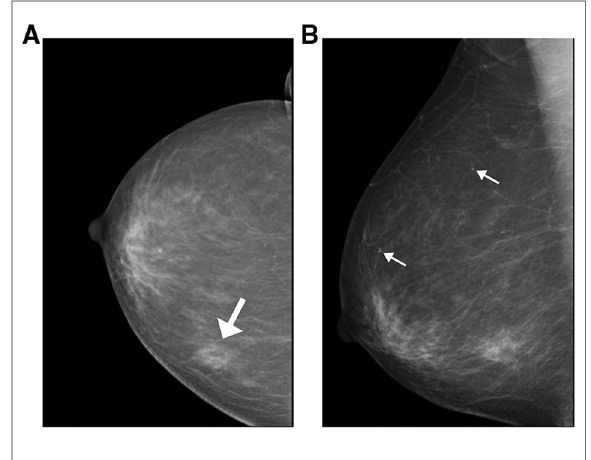
FIGURE 1 Mammographic fi ndings of patients with invasive ductal carcinoma with micropapillary features ( A ) a 74-year-old woman with a palpable abnormality in the left breast. A mass is visible in the posterior portion of the central area of the left breast, measuring approximately 1.7 cm×1.5 cm×1.8 cm; it is lobulated, with burrs visible at the edges and tiny calci fi cations visible within it (white arrow indicates the location of the breast mass). ( B ) A 74-year-old woman with a palpable abnormality in the right breast and fl occulent high-density shadowing in the lower quadrant. Associated pleomorphic microcalci fi cations are also visible within the breast (white arrows indicate the locations of microcalci fi